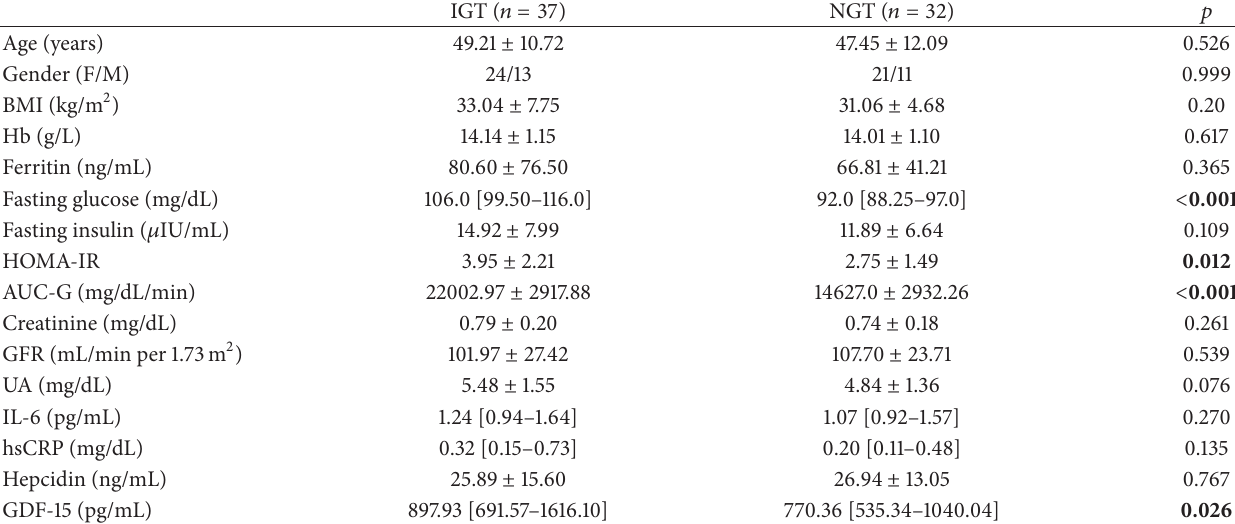
Table 1: Baseline characteristics of the patient and control groups.